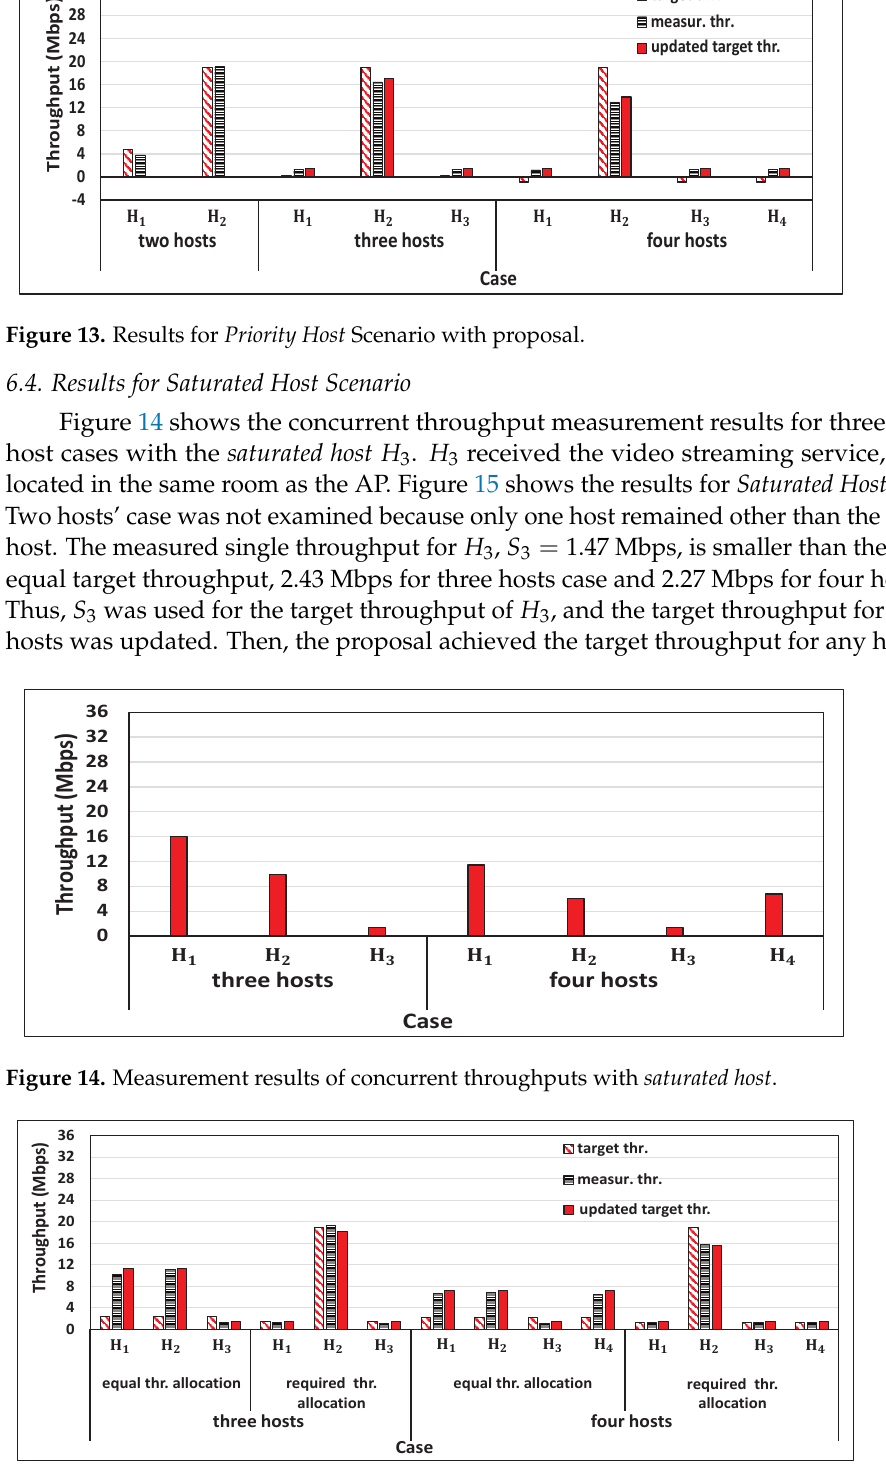
Figure 15. Results for Saturated Host with